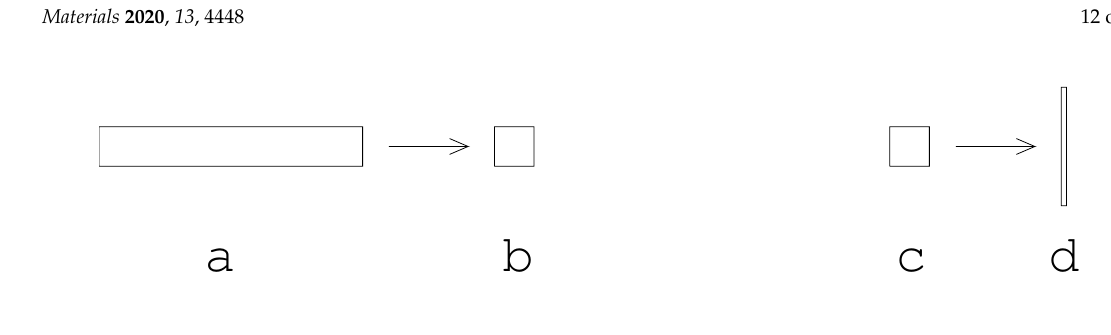
Figure 6. Meshing strategies in the aluminum near the copper: ( a ) and ( b ): graded strategy; ( c ) and ( d ): uniform